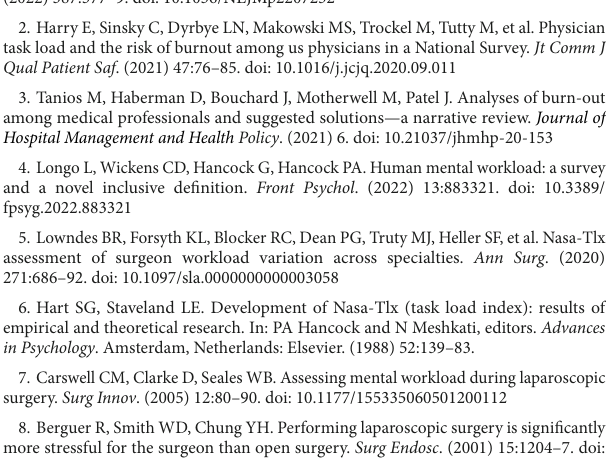
SUPPLEMENTARY FIGURE S2 The comparison of mental workload during ESS in association with OSATS score. Participants were classified into three groups according to their OSATS score (the top 1/3, the middle 1/3, and the bottom 1/3). Total score of NASA-TLX (A) , mental demand (B) , physical demand (C) , temporal demand (D) , performance (E) , effort (F) , and frustration (G) were compared amongst these three groups. ESS, Endoscopic sinus surgeries; OSATS, Objective Structured Assessment of Technical Skills; NASA-TLX, National Aeronautics and Space Administration-Task Load Index. ** p < 0.01, *** p <